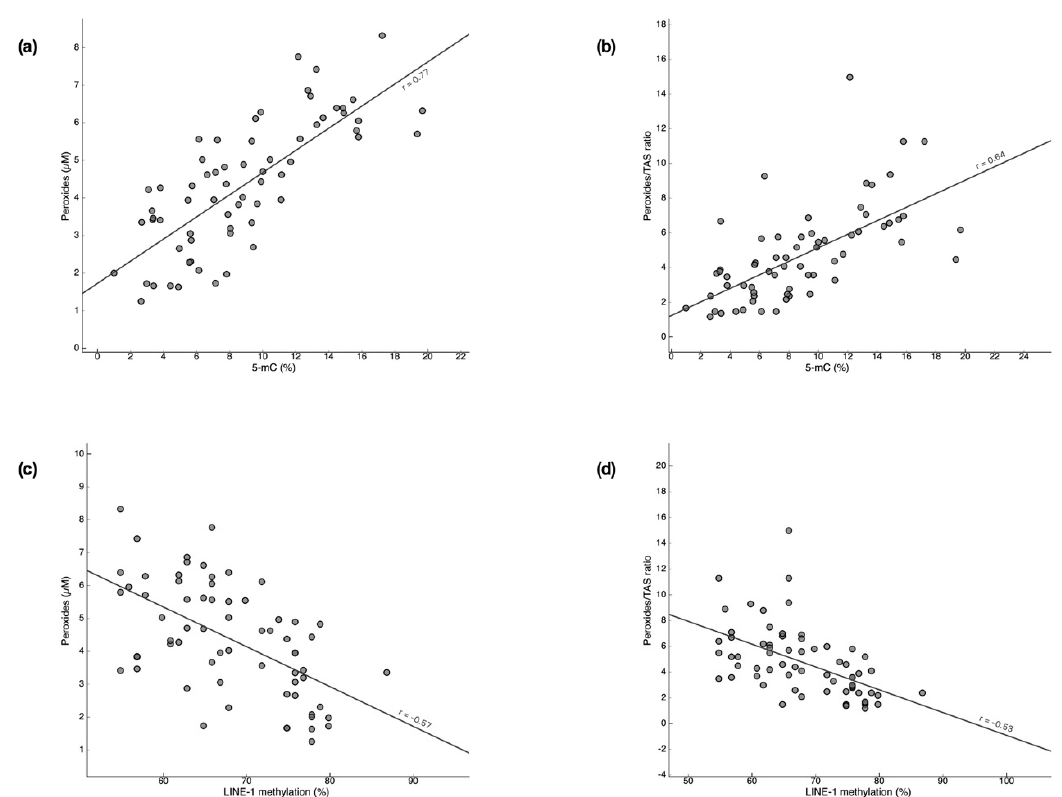
Figure 4. Correlation of oxidative stress parameters with global DNA methylation in myelodysplastic syndrome patients. The following correlations were observed: 5-methylcytosine (5-mC) with peroxides levels ( a ), 5-mC with peroxide/total antioxidant status (TAS) ratio ( b ), long interspersed nuclear element-1 (LINE-1) methylation with peroxides levels ( c ), and LINE-1 with peroxide/TAS ratio ( d ).